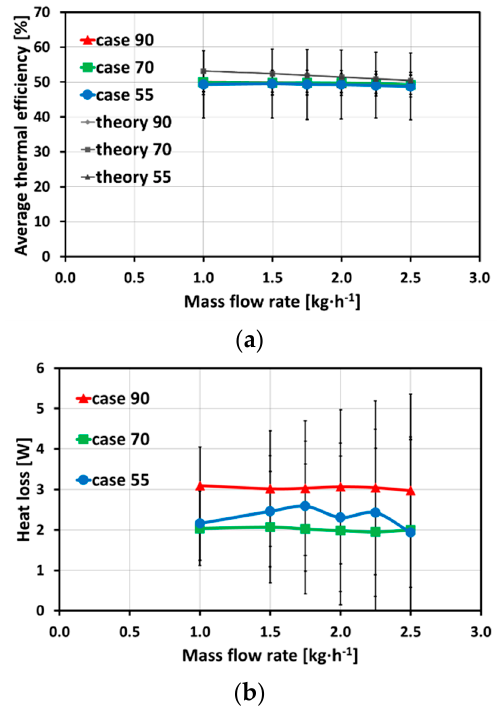
Figure 6. Average thermal efficiency ( a ) and heat loss ( b ) for straight micro channels with different temperature conditions (with a maximum uncertainty of the average thermal efficiency of Δ ε Th = ± 10.0% and a maximum uncertainty of Δ Q = ±2.4 W for case 90).